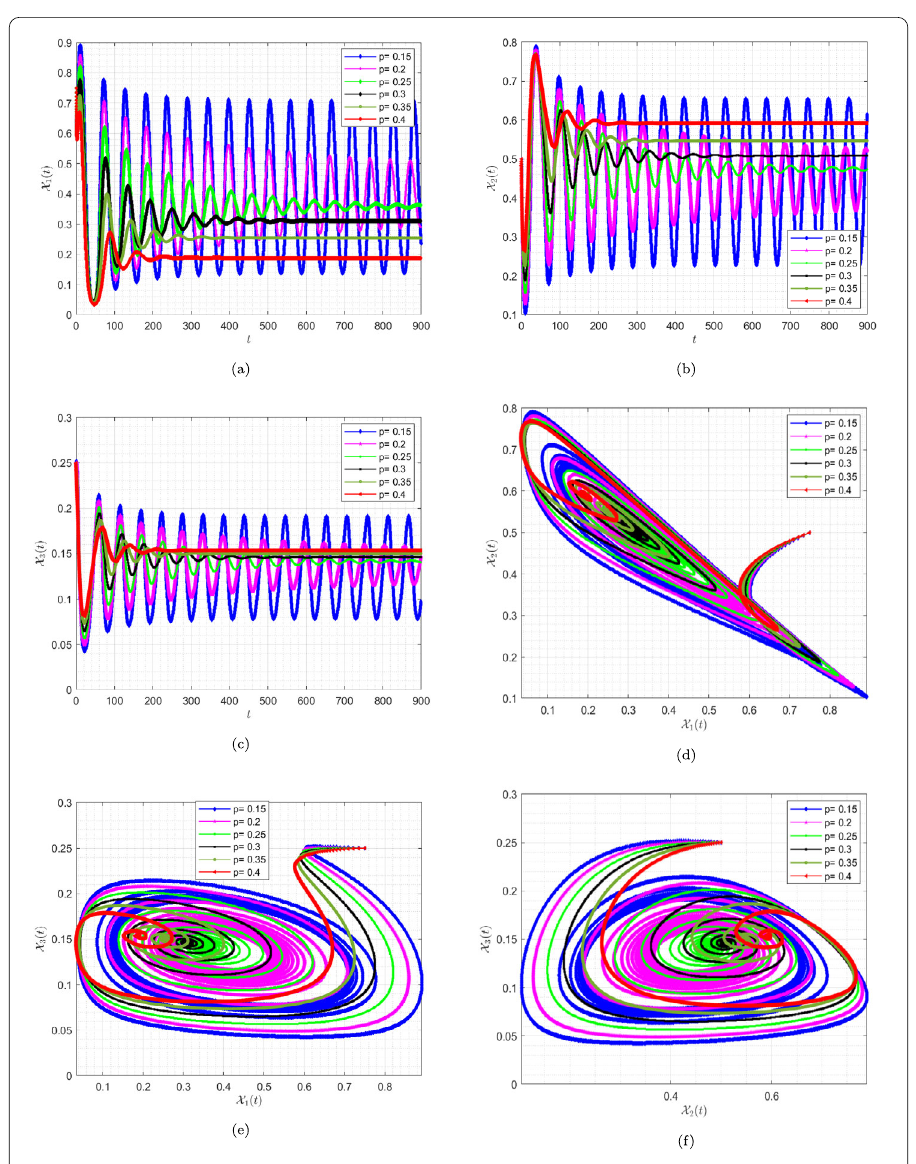
Figure 11 Dynamics for system (19) by taking different values of parameter m 1